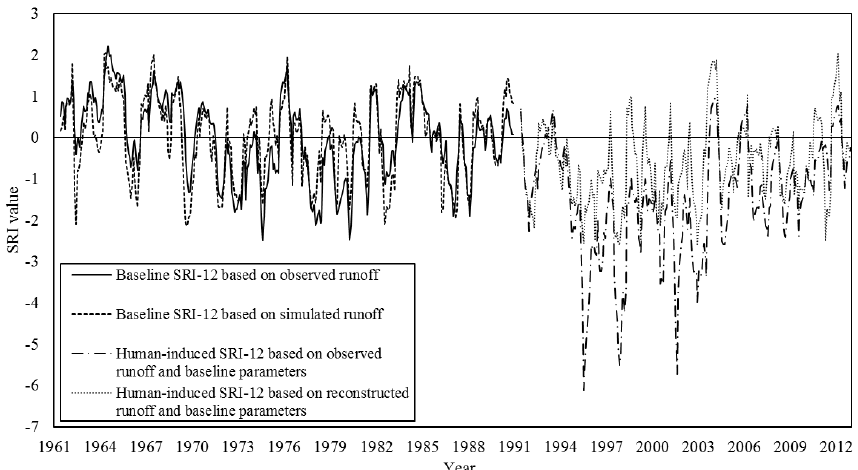
Figure 4. Standardized runoff index time series of 12-month accumulative runoff in baseline and variation periods at the Xianyang hydrologic